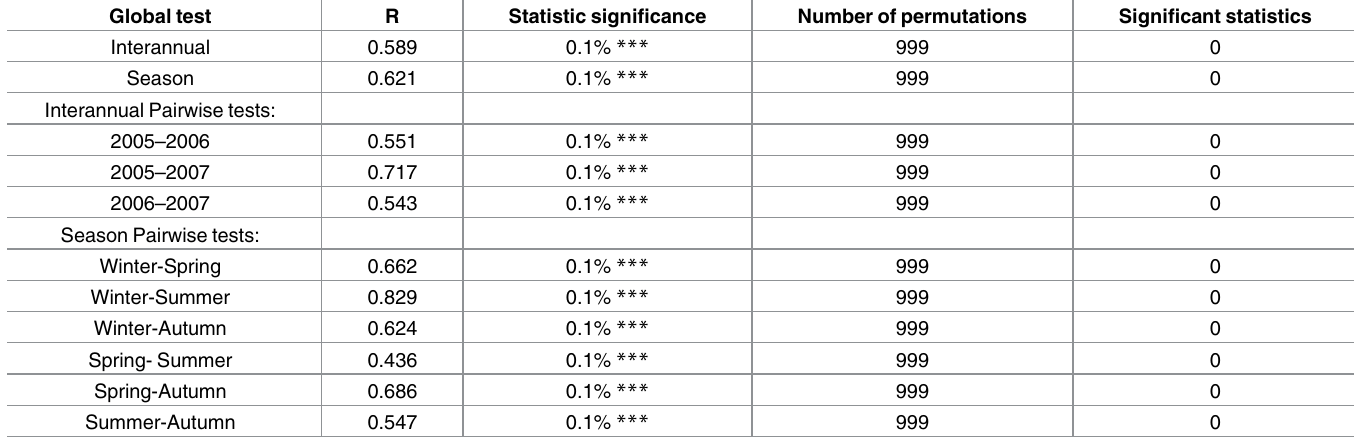
Table 1. Results of the two-way ANOSIM (global and pairwise tests) for the MDS performed with samples collected in 2005, 2006 and 2007 to assessinterannual and seasonal differences. 2004 was excludedbecauseit does not represent a completesamplingyear. The statistic estimated for each permutation is significantwhen its value is greater than or equal to the sample statistic. Significance level is calculatedas the percentage of significant statistics in the total numberof permutations used. R: Samplestatistic. Global test R Statistic significance Number of